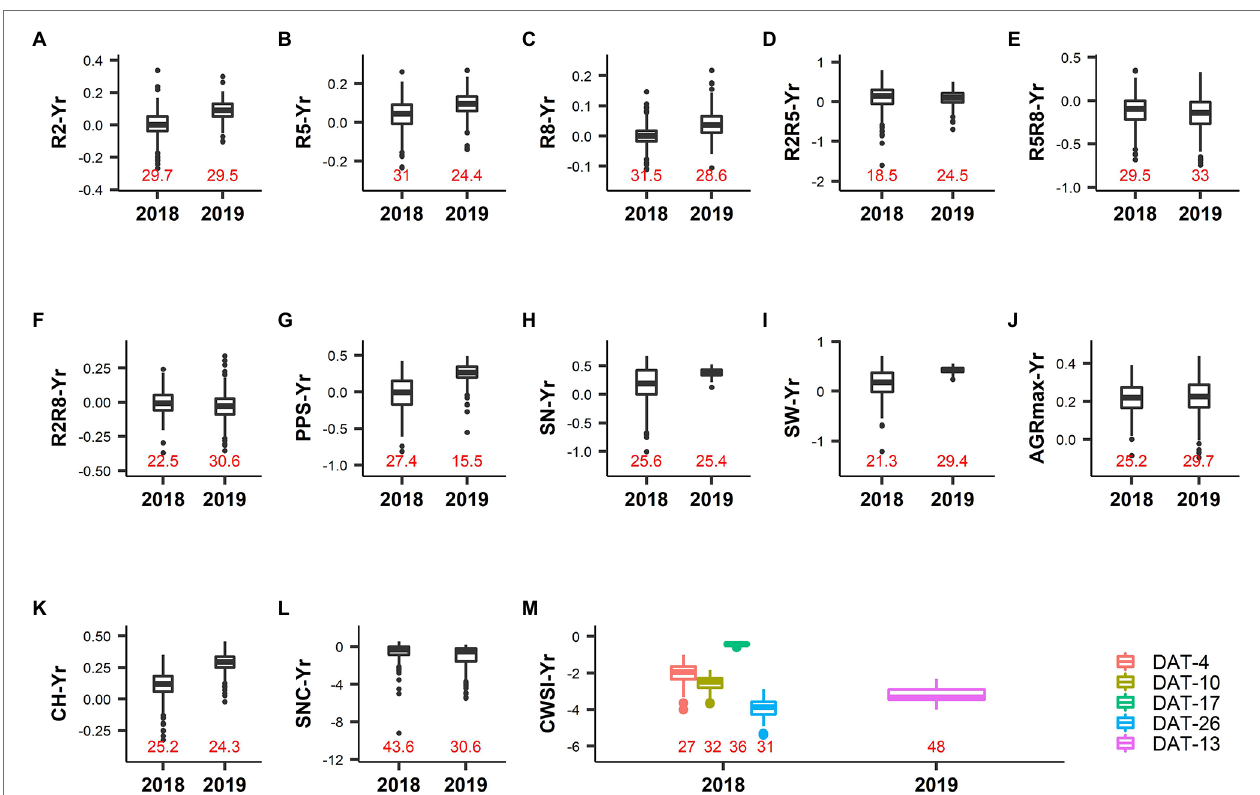
FIGURE 3 | Phenotypic variation in drought index values (Yr) of different traits. Labels on the X -axis represent the year of the experiment, and correspond to a short drought treatment (2018) and a long drought treatment (2019). The Y -axis represents the drought index value of the respective trait. Data labels inside the plot area (colored in red) indicate the value of the coefficient of variation determined from the normalized Yr data. (A) R2: Thermal time from sowing to full flowering. (B) R5: Thermal time from sowing to beginning seed. (C) R8: Thermal time from sowing to pod maturity. (D) R2R5: Duration of pod formation. (E) R5R8: Duration of seed development. (F) R2R8: Thermal time from full flowering to pod maturity. (G) PPS: Number of pods on the main stem. (H) SN: Number of seeds per plant. (I) SW: Seed weight per plant. (J) AGRmax: Maximum absolute growth rate. (K) CH: Maximum canopy height. (L) SNC: Rate of senescence. (M) CWSI: Crop water stress index. Legends represent the measurement day after drought treatment initiation